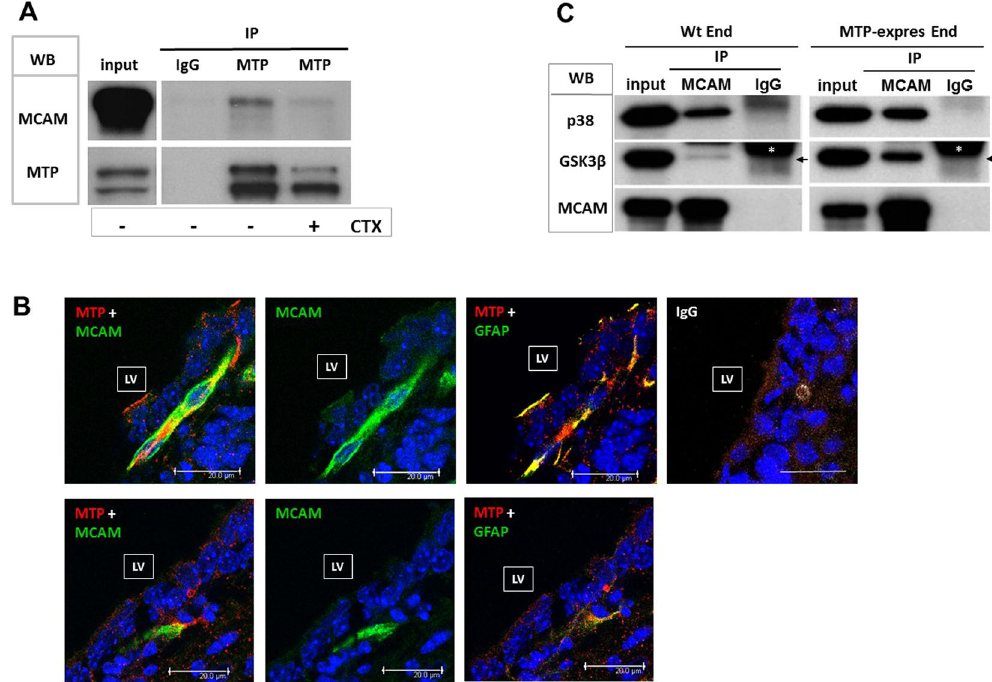
Figure 5. MTP and MCAM physically bind to each other and the binding is impaired by CTX. ( A ) MTP IP- MCAM Western of bEnd cells transfected with full-length MTP carrying both 6His and c-Myc tag proteins. Cell lysate were IP with c-Myc antibody to pull down MTP (MTP IP) or with control IgG of the same subtype (IgG IP) followed by Western blot (WB) with MCAM (MCAM) or 6His antibody (MTP). Cell culture in the absence or presence of CTX is indicated at bottom of the image ( − , + CTX). input: Western blots of the MTP-expressing bEnd cell lysate before IP. This figure is cropped from the original blot that is shown in Supplementary Fig. 2. The same results were observed in 3 independent experiments. ( B ) Brain tissue staining of MTP and MCAM. Images were taken from SVZ of the mouse brain lateral ventricle. Tissues were stained simultaneously with antibodies to MTP, MCAM and GFAP from different host species and visualized by Alexa 594, Alexa 488 and Cy5-conjugated secondary antibodies, respectively. GFAP is used to label SVZ NS/P cells. In GFAP and MTP combined image, GFAP staining was pseudo-colored in green for better viewing. LV indicates the location of lateral ventricle. IgG shows immunstaining with control IgG of the same subtypes. Scale bars represent 20 um. ( C ) Western blot of MCAM IP from bEnd cells (Wt-End) or bEnd cells transfected with full-length MTP carrying both 6His and c-Myc tag proteins (MTP-expres End). Cell lysates were IP with MCAM antibody (IP MCAM) or with control IgG of the same subtype (IP IgG) followed by Western blot (WB) with antibody to p38, GSK3 β or MCAM. A small portion of cell lysates were subjected to WB without IP as input control (input). Arrows localize the expected protein bands. White stars indicate the location of